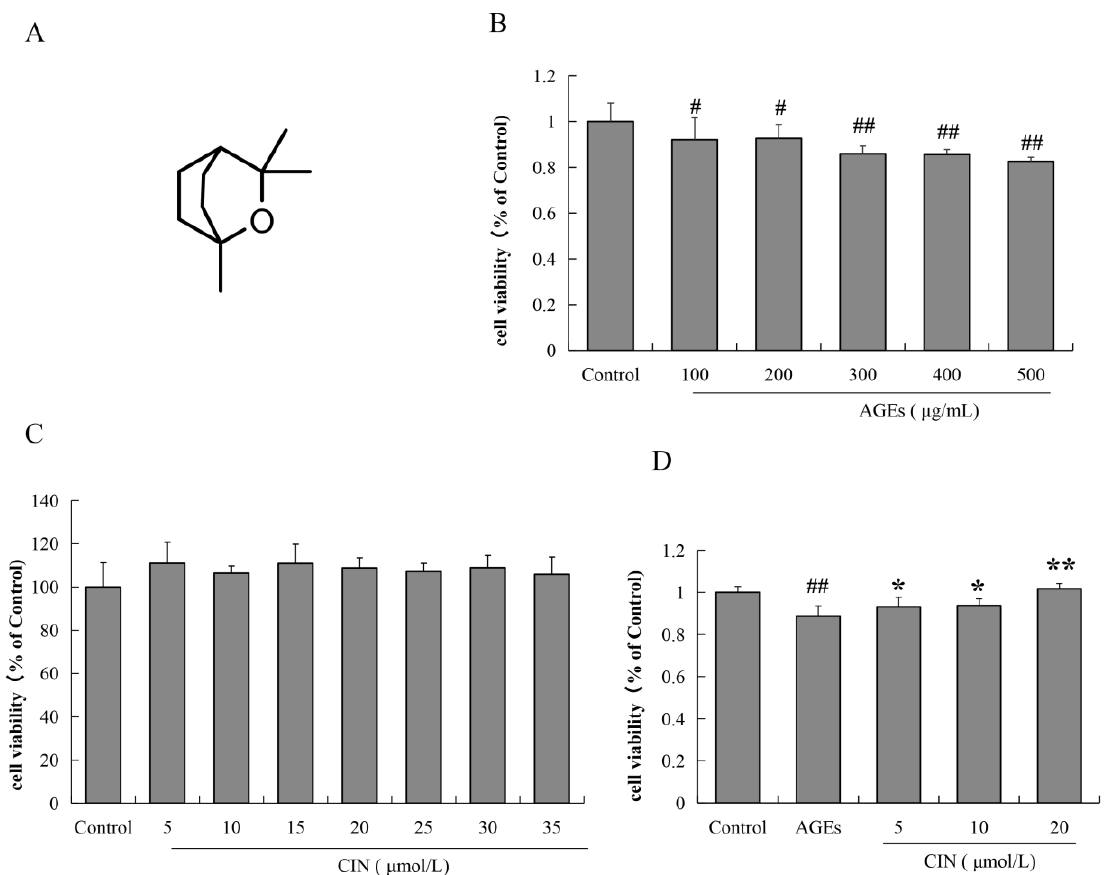
Figure 1. The chemical structure of CIN and the effects of AGEs and CIN on SH-SY5Y cell viability. ( A ) Chemical structure of CIN. ( B ) The MTT assay was used to detect the effect of AGEs on SH- SY5Y cell activity. ( C ) The MTT assay was used to detect the effect of CIN on SH-SY5Y cell activity. ( D ) The MTT assay was used to detect the effect of CIN on AGEs-induced SH-SY5Y cell activity. n = 6. # p < 0.05, ## p < 0.01 vs. the control group; * p < 0.05, ** p < 0.01 vs. the model group.